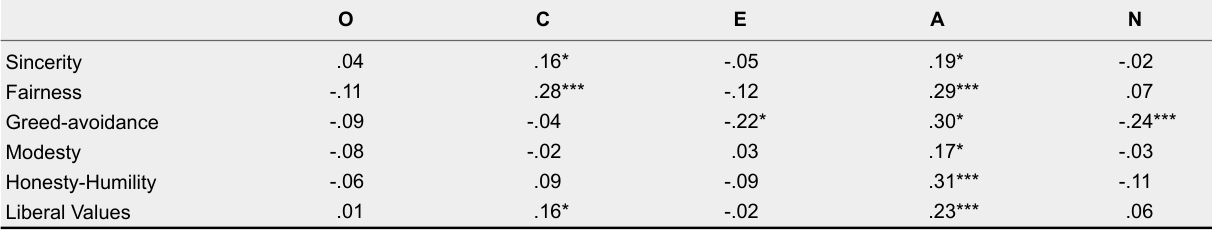
Correlations Between the Big Five, Honesty-Humility, and Liberal Values